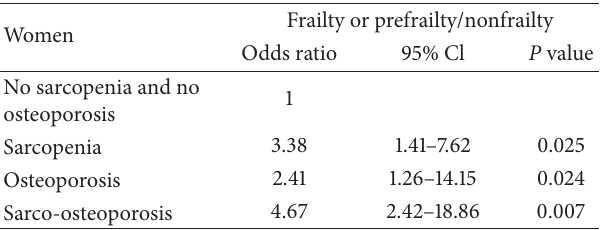
Table 7: Association between sarco-osteoporosis, sarcopenia, or osteoporosis and frailty/prefrailty in